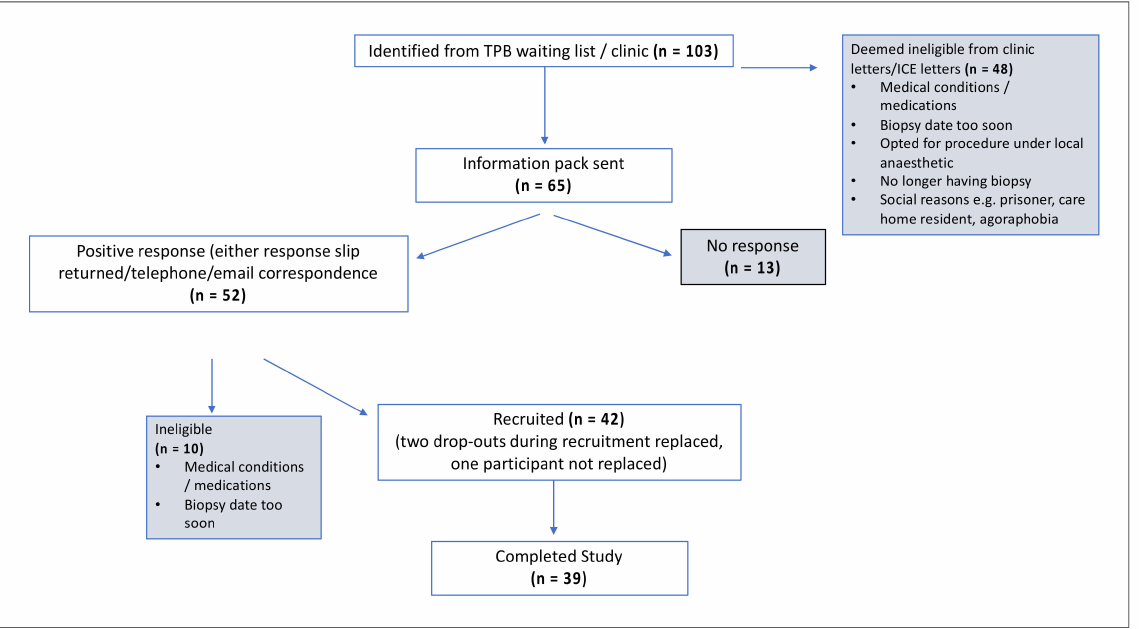
Figure 2. CONSORT diagram with the participant route through the